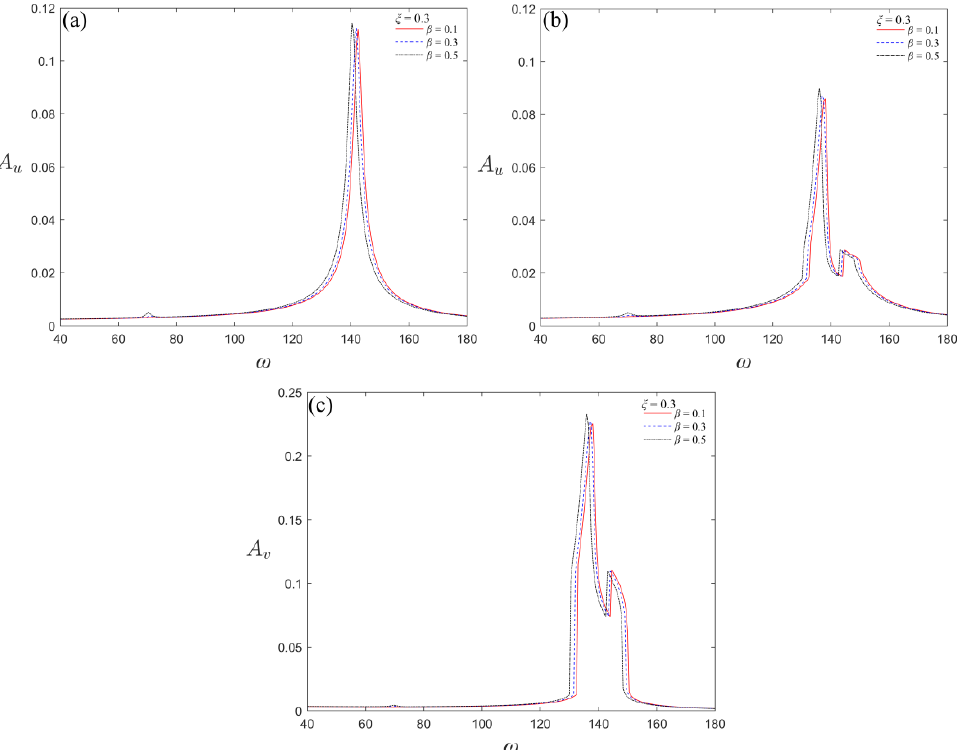
Figure 5. Phase diagram of the system at 133 rad/s; ( a ) phase diagram of beam in the beam–NES system and ( b ) phase diagram of NES. Figure 6. Waveforms of beam and NES in the beam–NES system with ξ = 0.3, β = 0.1, 0.3, and 0.5; ( a ) waveforms of beam in the beam–NES system, ( b ) waveforms of NES; red line: β = 0.1, blue line: β = 0.3, black line: β = 0.5. It can be seen in Figure 6 that, for the excitation frequency equal to 133 rad/s, the amplitude of both the beam and NES in the beam–NES system increases with β . However, the beam amplitude always remains low, while the NES amplitude increases greatly, re- sulting in an obvious signal amplification effect. Based on the above analysis, the change in crack parameters inevitably leads to a change in the phase diagram. In addition, the phase diagram includes both the displace-